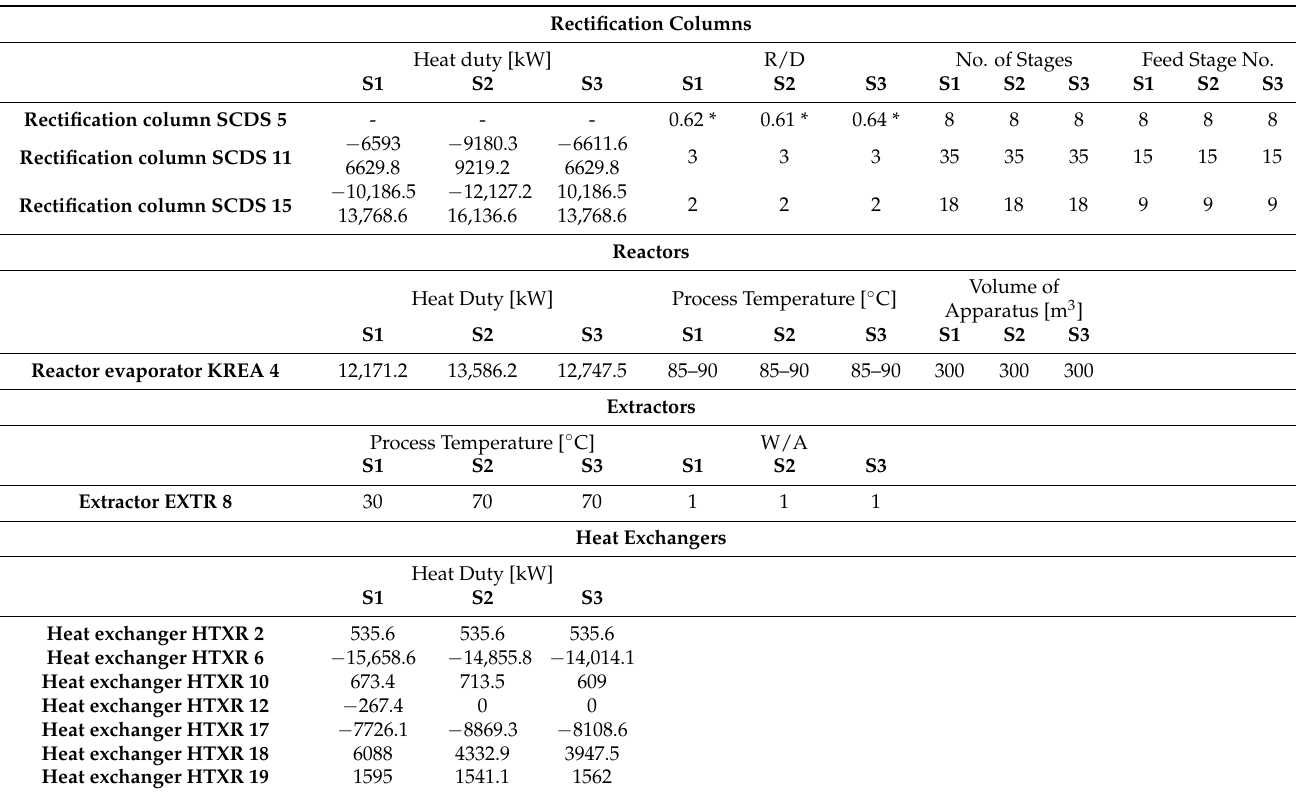
Table 1. A list of apparatus operating parameters for the improved approach and for the classic approach of the installation to produce EA (* R/V—reflux/vapor